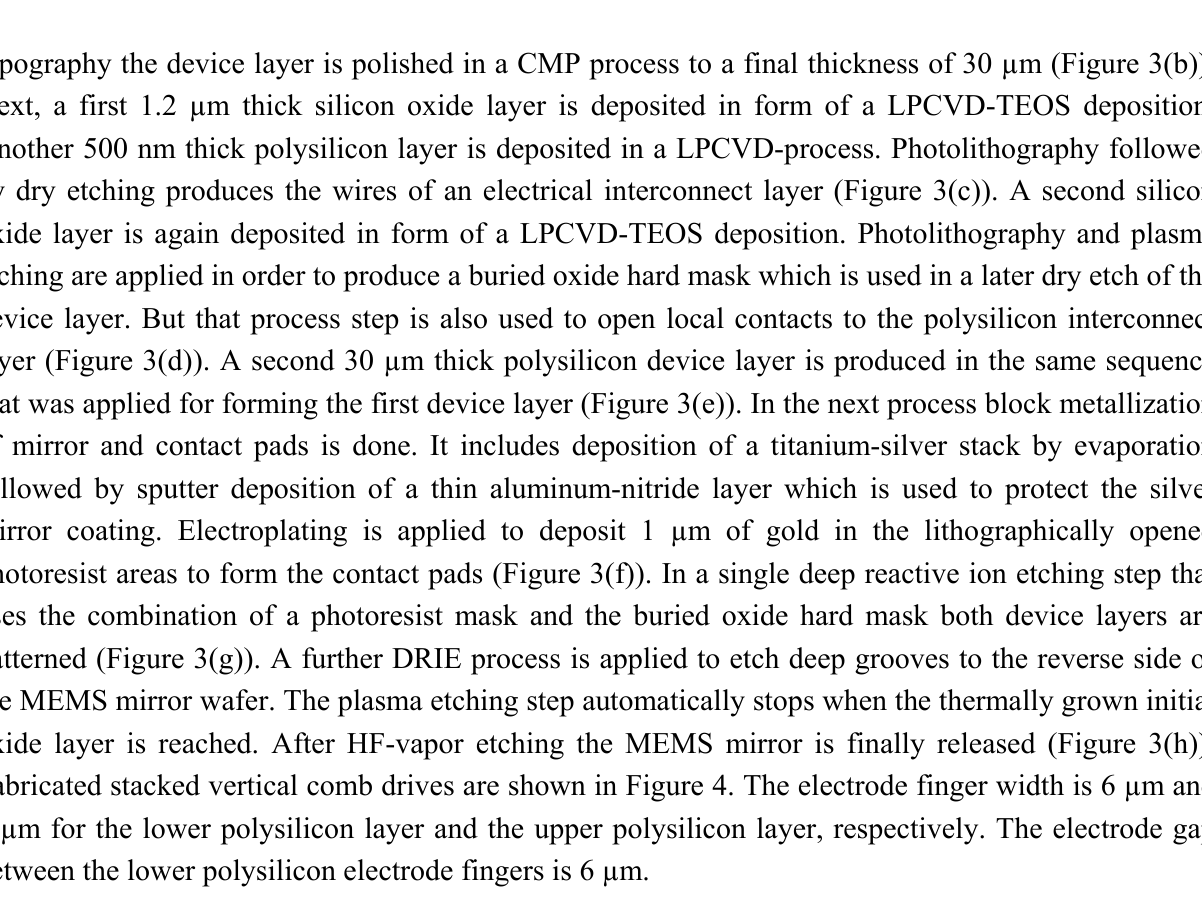
Figure 3. MEMS mirror fabrication